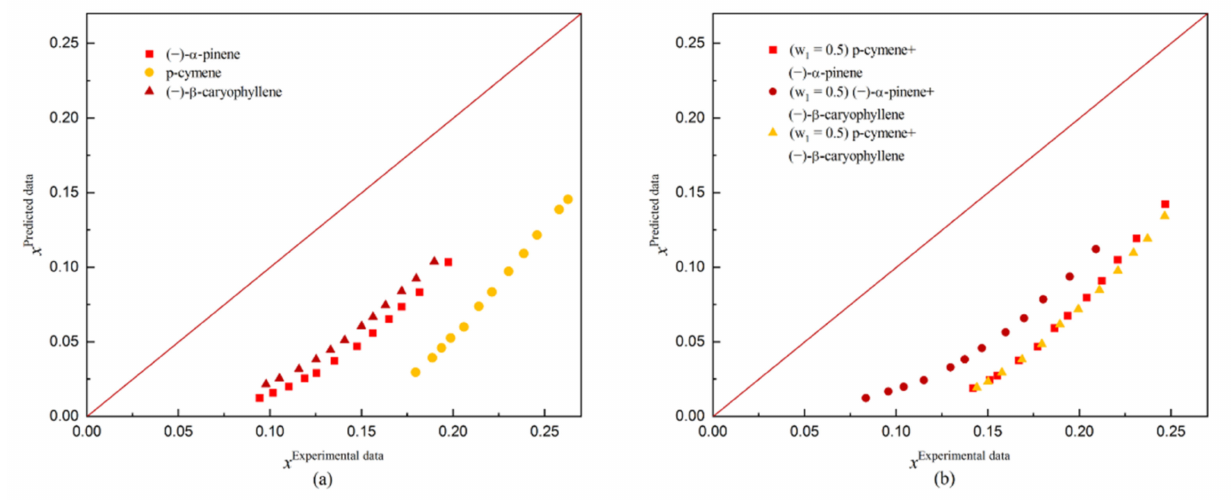
Figure 7. Comparison of COSMO-RS predicted and experimental solubility of dehydroabietic acid: ( a ) indicates the comparison in monosolvents; and ( b ) indicates the comparison in binary solvents.